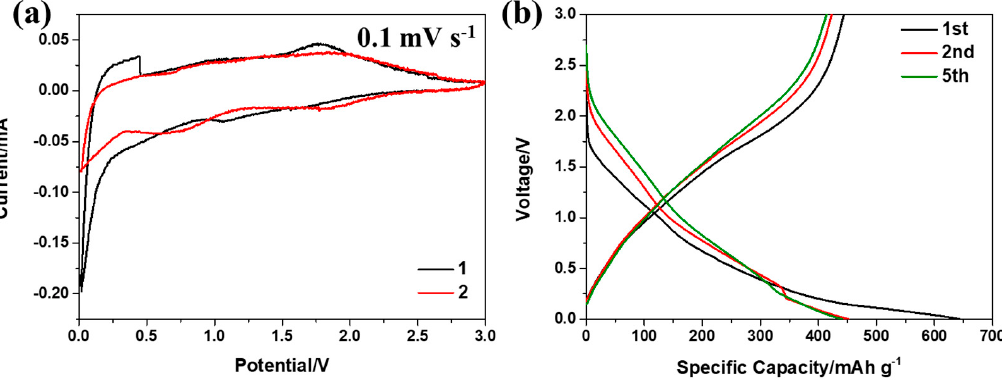
Figure 5. ( a ) CV curves under a scan rate of 0.1 mV s − 1 for the first two cycles; ( b ) charge-discharge curve of 1st, 2nd, 5th cycles at a current density of 100 mA g − 1.